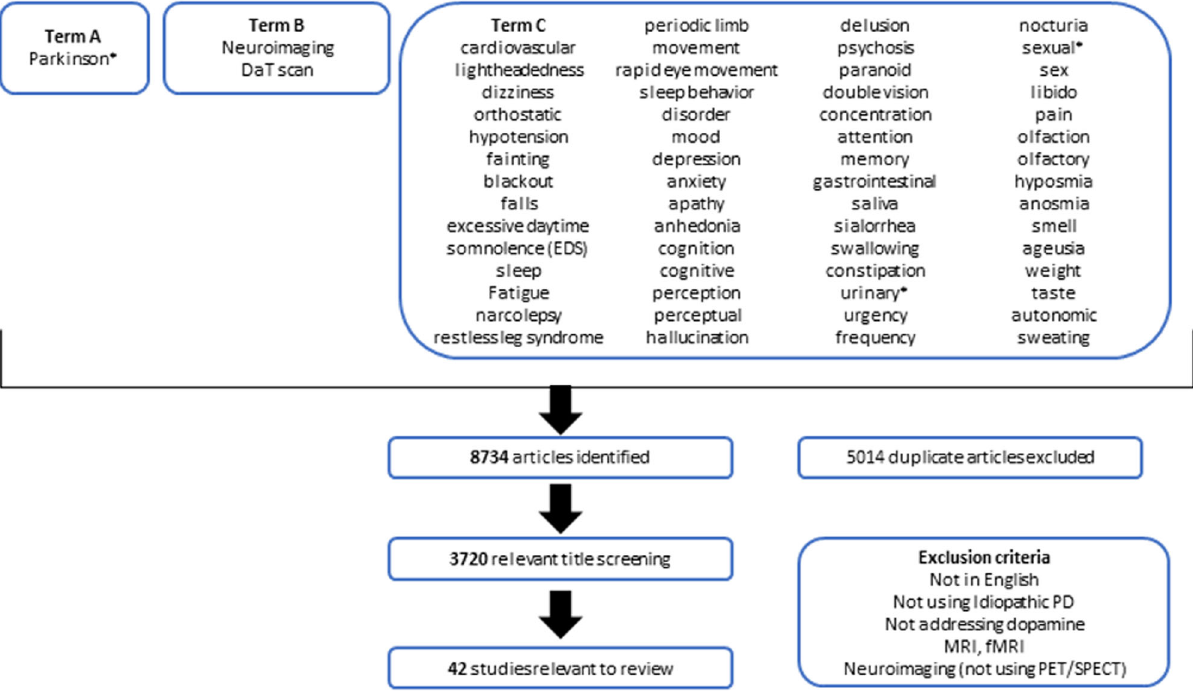
Fig. 2 Methodology used for this review. DaT dopamine transporter, EDS excessive daytime somnolence, MRI magnetic resonance imaging, fMRI functional MRI, PET position emission tomography, SPECT single positron emission computed tomography, PD Parkinson ’ s